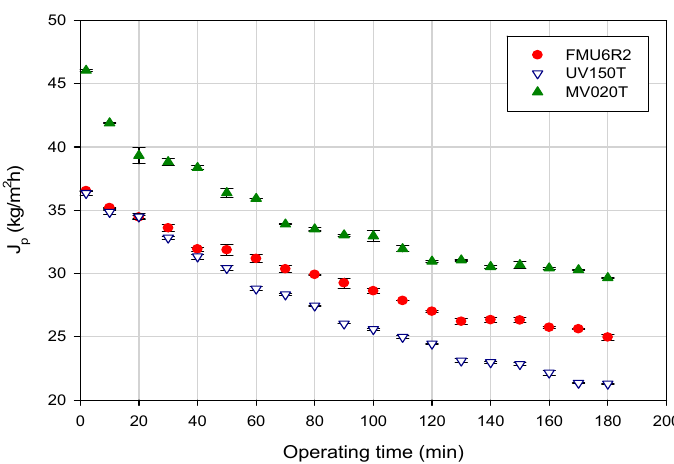
Figure 2. Time course of permeate flux for selected membranes under total recycle configuration. Operating conditions: TMP, 1 bar; temperature, 26.0 ± 1.0 °C; feed flowrate, 185 L/h.